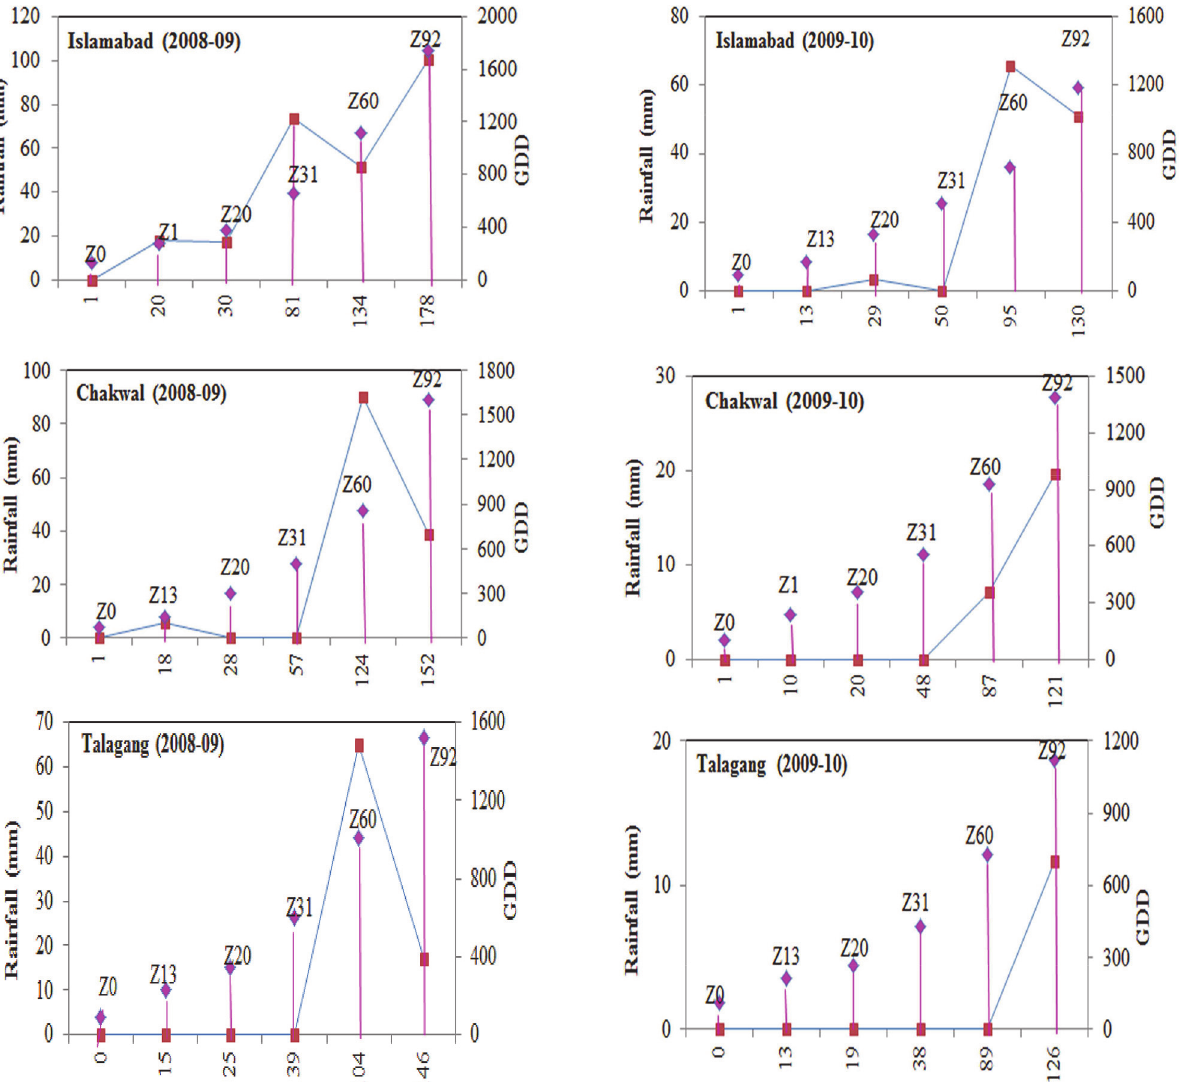
Fig 2. Mean phenological development (Zadok (Z) Scale) of wheat genotypes in relationship to rainfall (Maroon marker with solid blue line)() and Growing Degree Days (GDD) (Pink marker with blue border line) at three study sites during two environments (2008 – 09 and 2009 – 10) averaged over five sowing dates